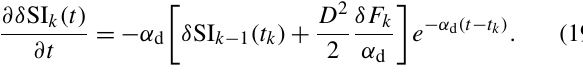
Fig. 8b. The event starts off with an initial destratification of − 0 . 48 m 2 s − 2 and ends at − 0 . 41 m 2 s − 2 , a net restratification of 0.07 m 2 s − 2 . This is despite the fact that this event has a positive δF k value of 3 . 80 × 10 − 8 s − 2 d − 1 (from Table